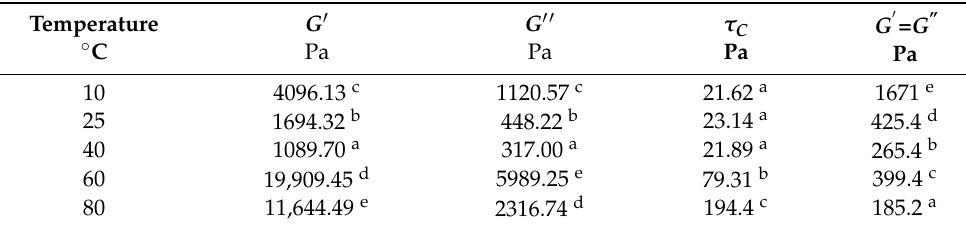
Table 3. The viscoelastic parameters were obtained with the stress sweep test of hydrocolloids from Pereskia bleo